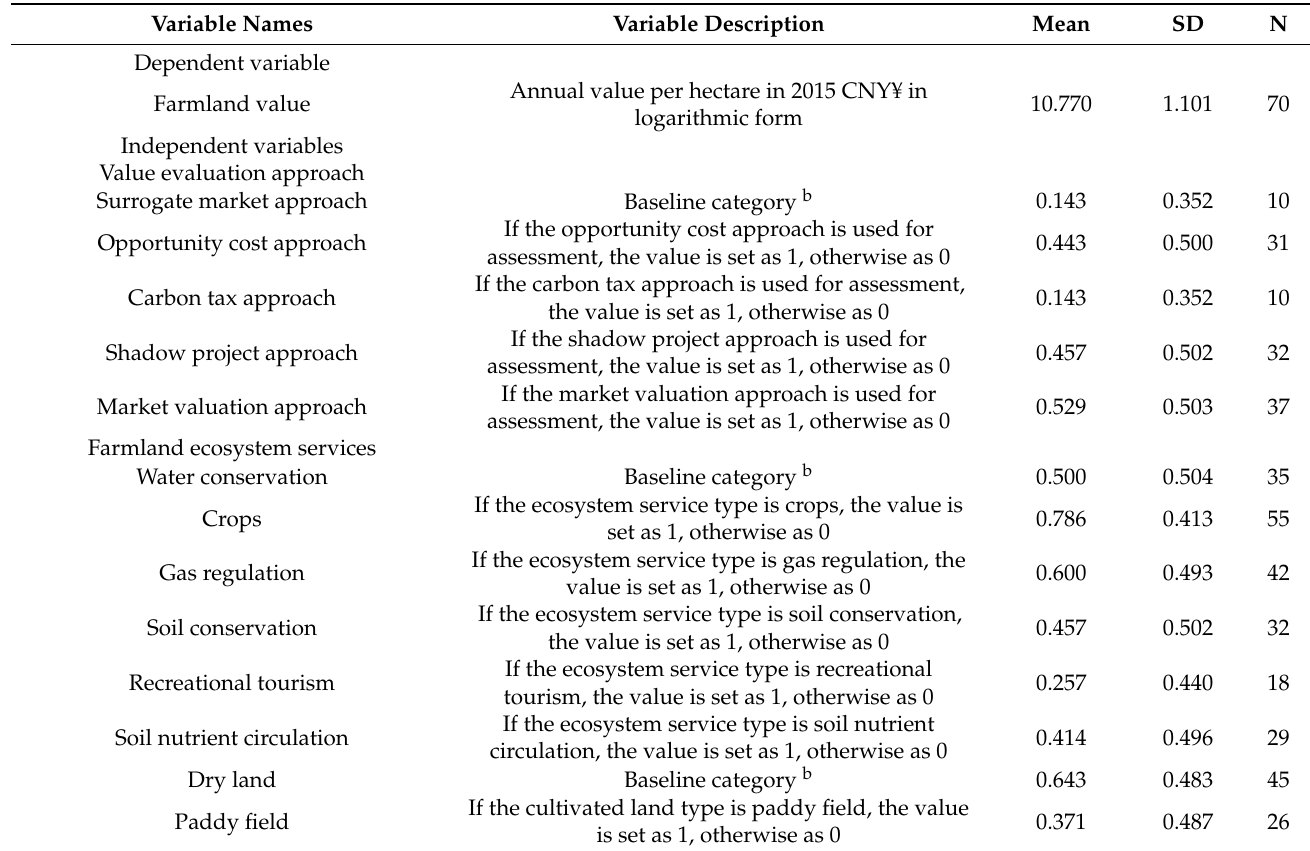
Table 1. Variable definitions and summary statistics a (in CNY¥ ha − 1 yr − 1